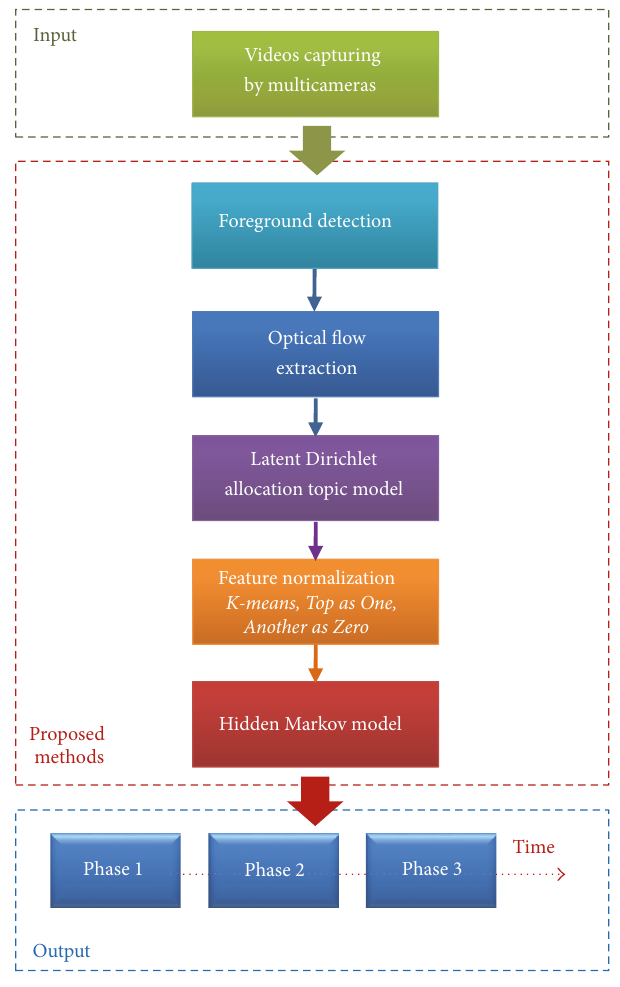
Figure 1: Overview of our proposed system.